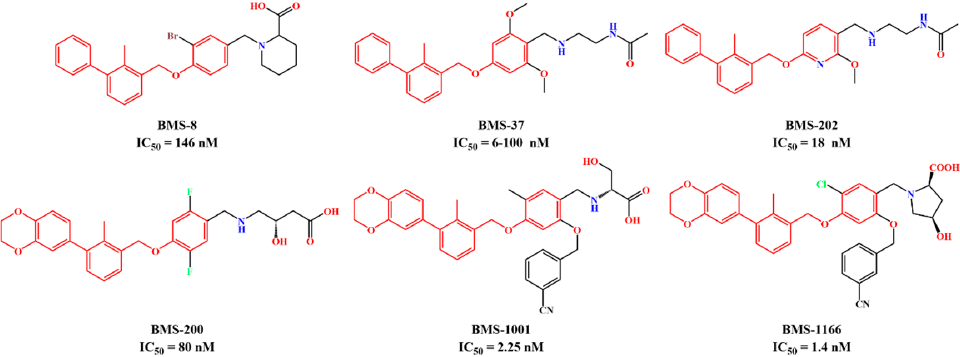
Figure 1. Two representative scaffolds of BMS small molecule inhibitors with IC 50 values assayed by HTRF.